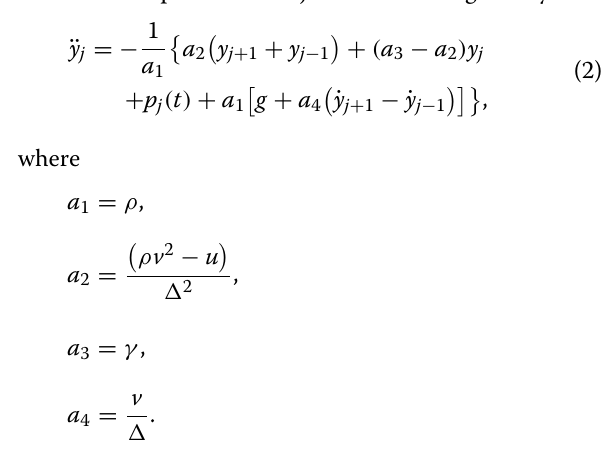
the longitudinal vibration and the transverse vibration. The